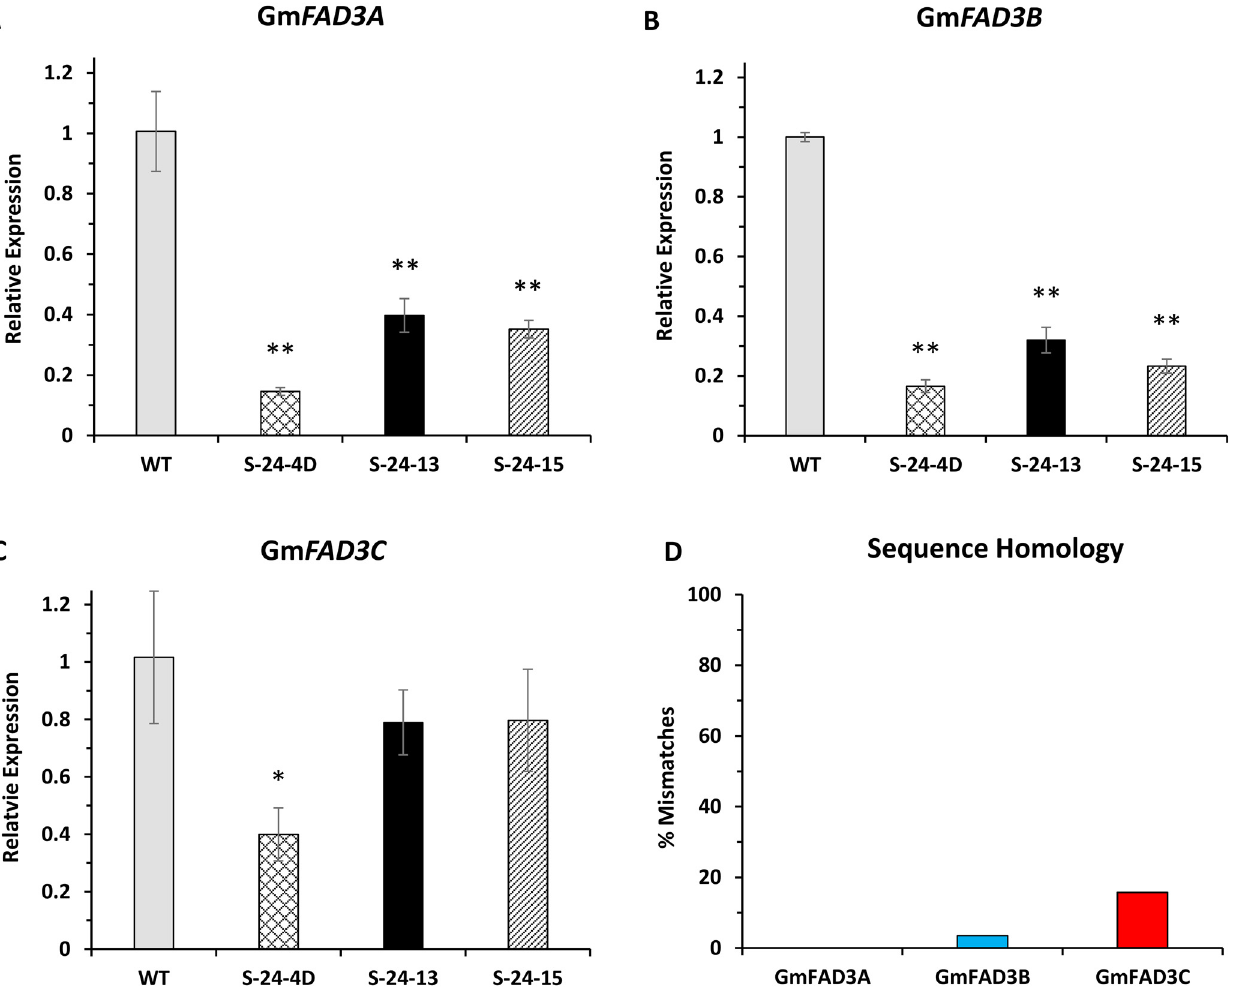
Fig 1. FAD3 gene expression level of T 5 homozygous RNAi lines. Data are averages of biological triplicates ± SD normalized to CONS7 mRNA. Independent-Samples T Test was used to test the significance. Asterisks indicate significant differences in relative expression between transgenic lines and control. ( * , p < 0.05; ** , p < 0.01). S24-4D, S-24-13, S-24-15 are T 5 homozygous for the pMUFAD transgene. Soybean cultivar Jack is used as wild-type control. (A) to (C) Normalized gene expression level of Gm FAD3A , Gm FAD3B and Gm FAD3C , respectively. The values of wild-type plants were arbitrarily fixed to 1.0. (D) Percentage of mismatches between the 318-bp IR and corresponding regions in GmFAD3A , Gm FAD3B and Gm FAD3C , respectively.